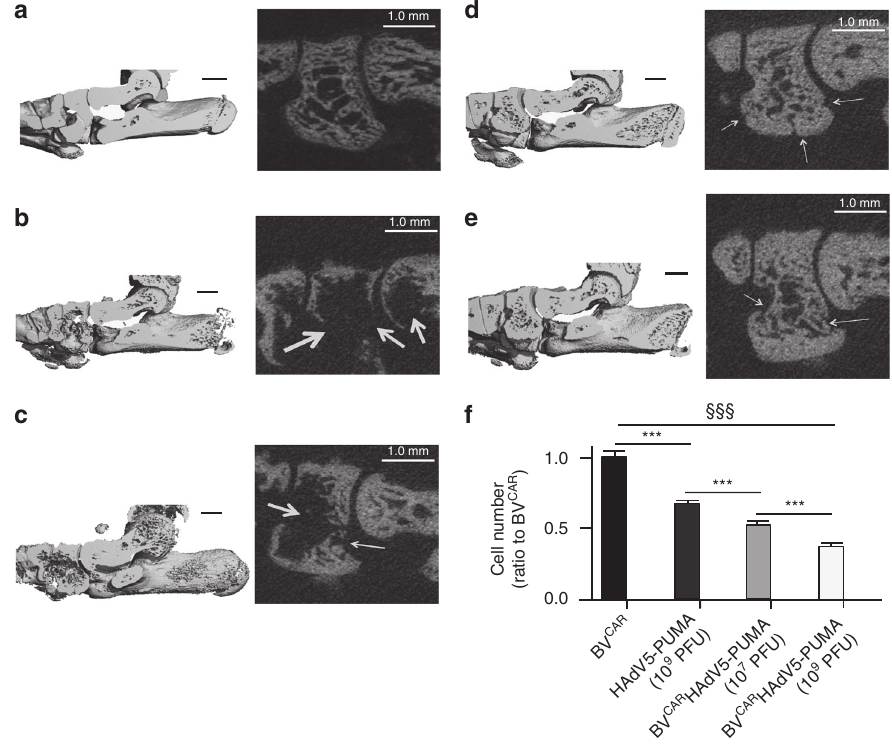
Fig. 5 Analysis of rat ankle tissues. Ankle tissue imaging by micro-computed tomography ( µ -CT) was performed on rat ankle joints from a a healthy rat, rats injected with b BV CAR alone, c HAdV5-PUMA alone and animals injected with BV CAR HAdV5-PUMA at vector doses of d 10 7 PFU per joint, and e 10 9 PFU per joint respectively. ( left ) Parasagittal three-dimensional views of the whole rat ankles. ( right ) The enlarged images of the µ -CT parasagittal slices showing, from left to right , the intermediate cuneiform, navicular and distal talus. The white arrows point at local bone erosions. Scale bars, 1mm. f Histological analysis and quanti fi cation of in fi ltrates was also performed. The bar graph shows the number of in fi ltrating cells, expressed as the ratio to their number in BV CAR control samples (mean ± s.e.m.; data from 30 slides per group). ANOVA: analysis of variance; §§§: ANOVA, P < 0.001; *** P < 0.0001 by Newman – Keuls post-hoc tests. Note that (i) BV CAR HAdV5-PUMA strongly reduced the density of in fl ammatory cells in the joints, compared to control BV CAR or HAdV5-PUMA; (ii) BV CAR HAdV5-PUMA was more effective at 10 9 PFU, compared to 10 7 PFU, demonstrating a dose-dependent